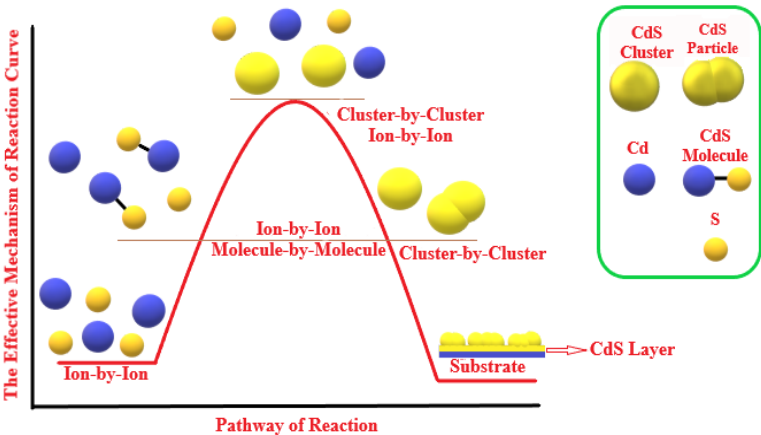
Figure 10. Curve of path of the CdS thin film mechanism.